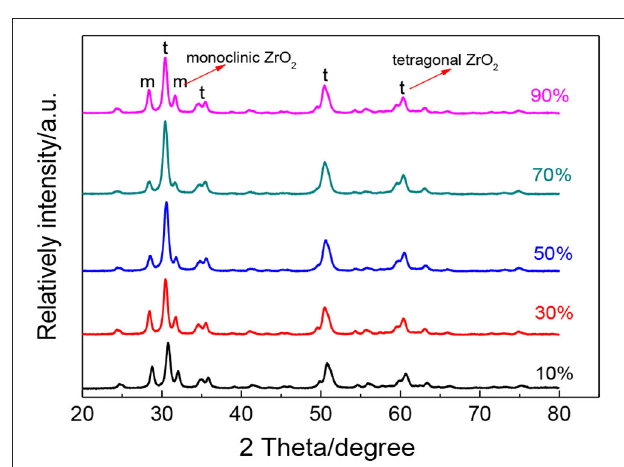
FIGURE 6 | XRD patterns of ZrO 2 materials synthesized with different ultrasonic power densities when the molar ratio of precursor to precipitant is 1:1 and ultrasonic time is